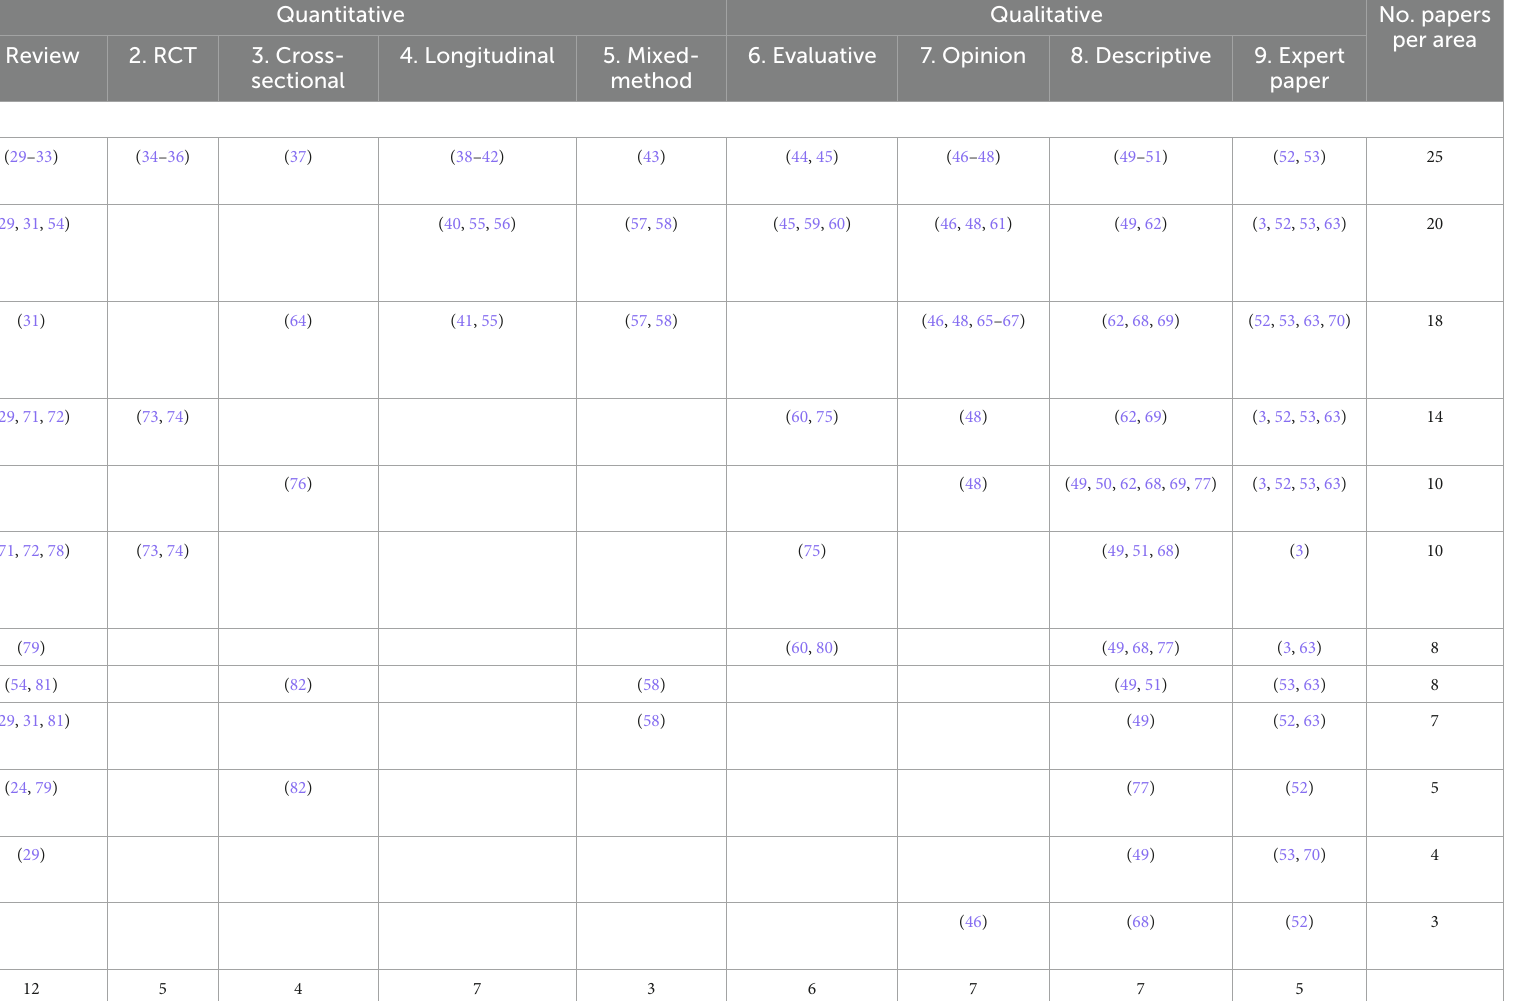
TABLE 2 Results of the thematic